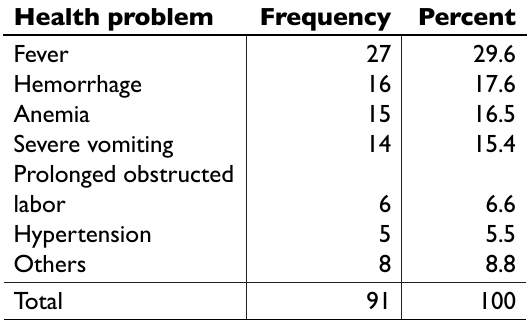
Health problems experienced in the last pregnancy Health